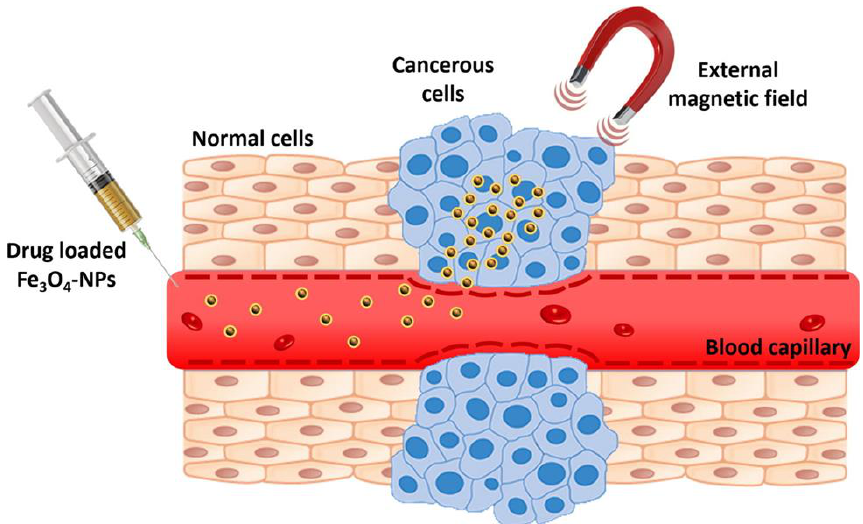
Figure 4. Schematic representation of targeted drug delivery using iron oxide NPs. Reproduced from [3], Elsevier B.V., 2020.